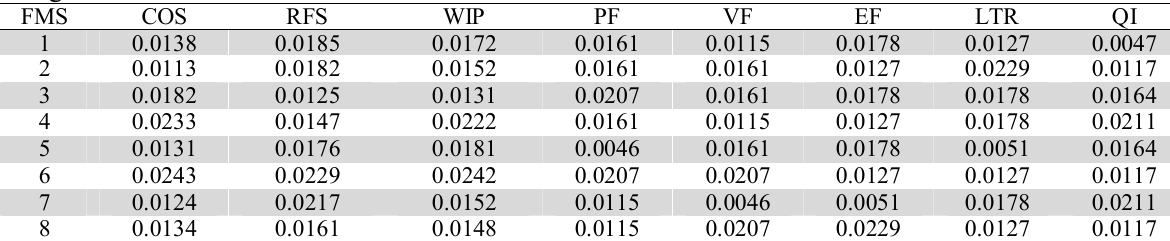
Weighted normalized decision matrix for COPRAS method